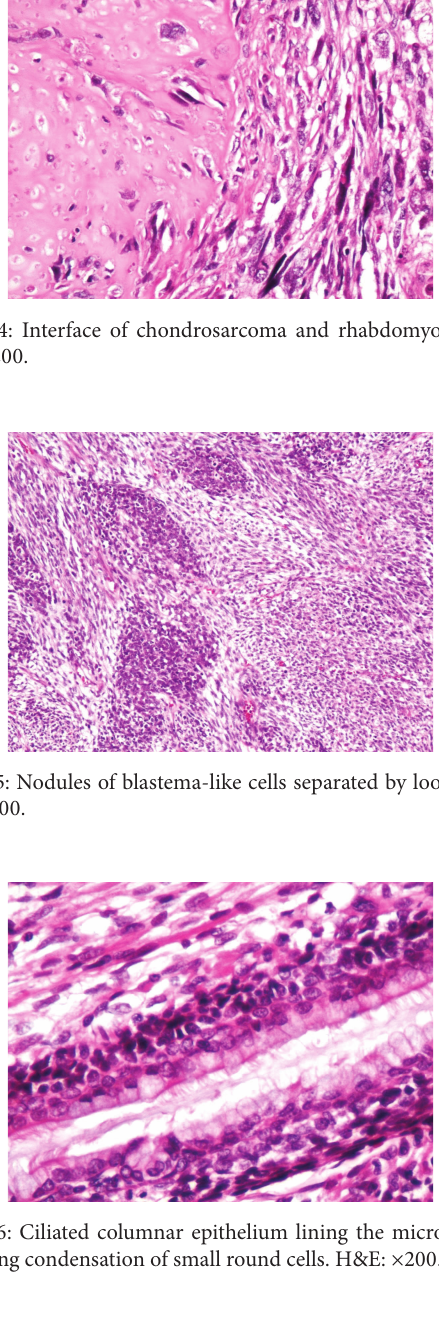
Figure 3: Islands of mature and immature hyaline cartilage. H&E: × 100.